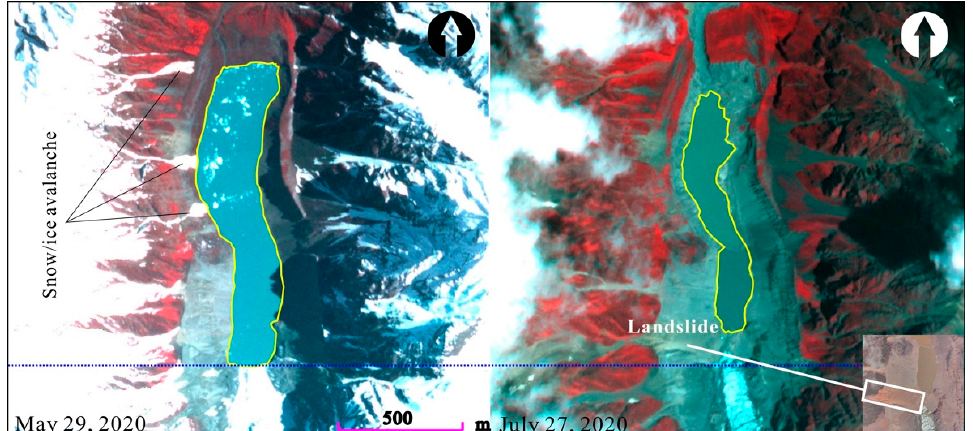
Figure 2. Near infrared combined image of Jinwuco glacier lake (left: before the outburst on May 29; right: after the outburst on 27 July 2020) (The blue dotted line is the end of the glacier; Avalanches or ice avalanches are the black lines on the left; the white frame is the site of landslide on the right) Image source: